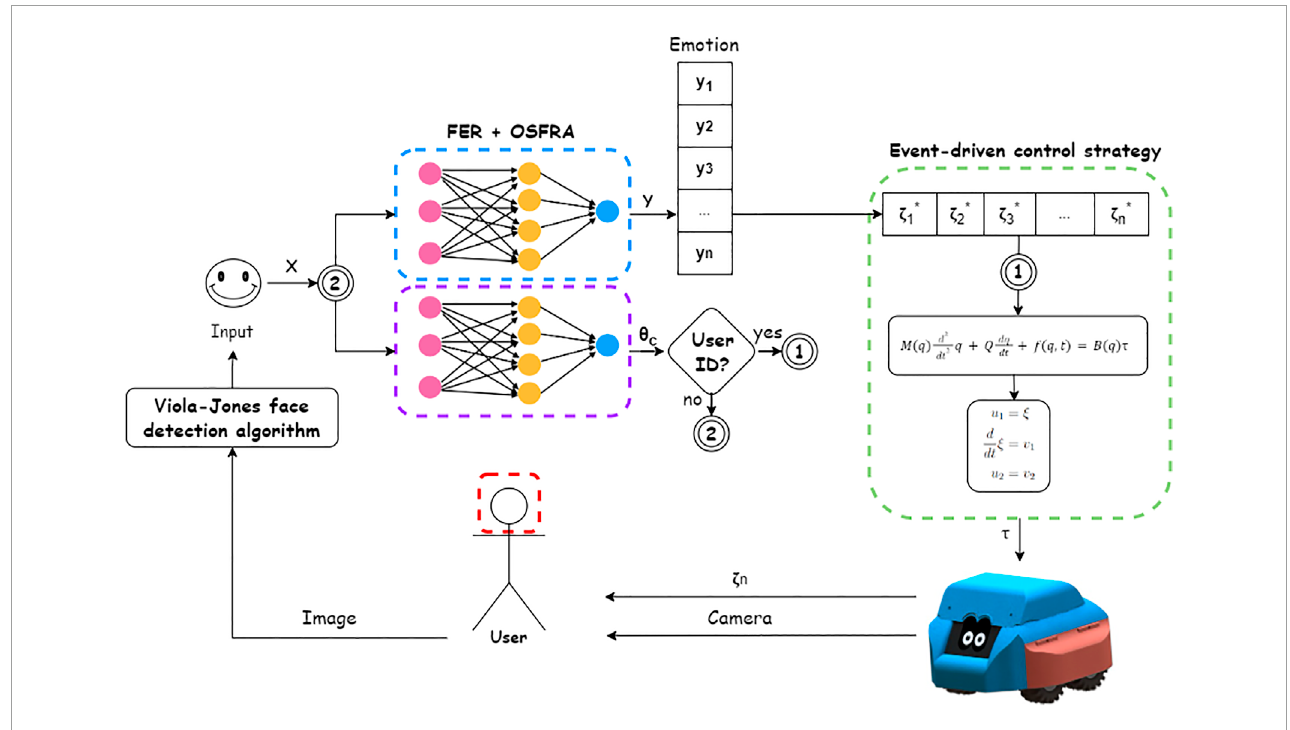
FIGURE 1 Scheme of the proposed broadcast event-driven control strategy.